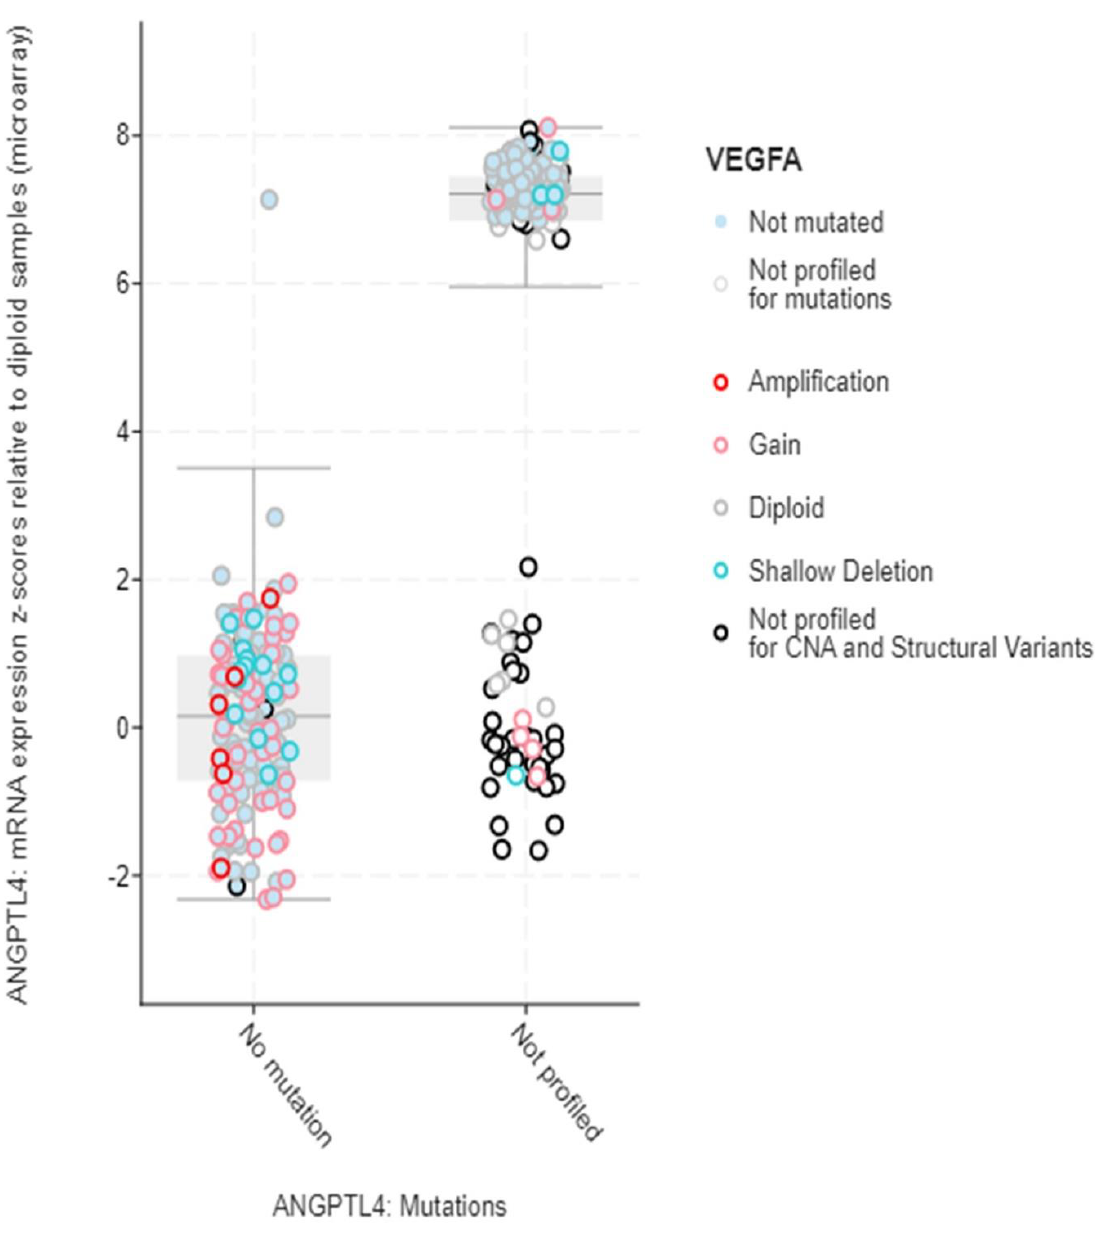
Figure 7. mRNA expression vs. VEGFA.